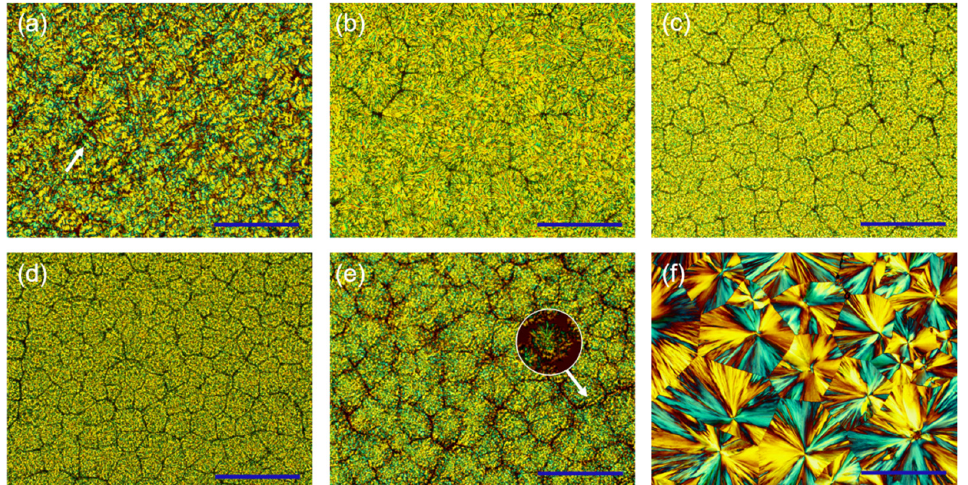
Figure 9. POM images of PBF ‐ UPy ( a ) isothermally crystallized at 120 °C, PBS ‐ UPy/PBF ‐ Upy blends ( b – e ) isothermally crystallized at 115 °C and PBS ‐ UPy ( f ) isothermally crystallized at 100 °C. ( b – e ) blends ( b – e ) isothermally crystallized at 115 ◦ C and PBS-UPy ( f ) isothermally crystallized at 100 ◦ C. indicate PBS ‐ UPy/PBF ‐ UPy ‐ 20/80, PBS ‐ UPy/PBF ‐ UPy ‐ 40/60, PBS ‐ UPy/PBF ‐ UPy ‐ 60/40, PBS ‐ ( b – e ) indicate PBS-UPy/PBF-UPy-20/80, PBS-UPy/PBF-UPy-40/60, PBS-UPy/PBF-UPy-60/40, PBS- UPy/PBF ‐ UPy ‐ 80/20, respectively. All scale bars are 200 μ m in length. UPy/PBF-UPy-80/20, respectively. All scale bars are 200 µ m in